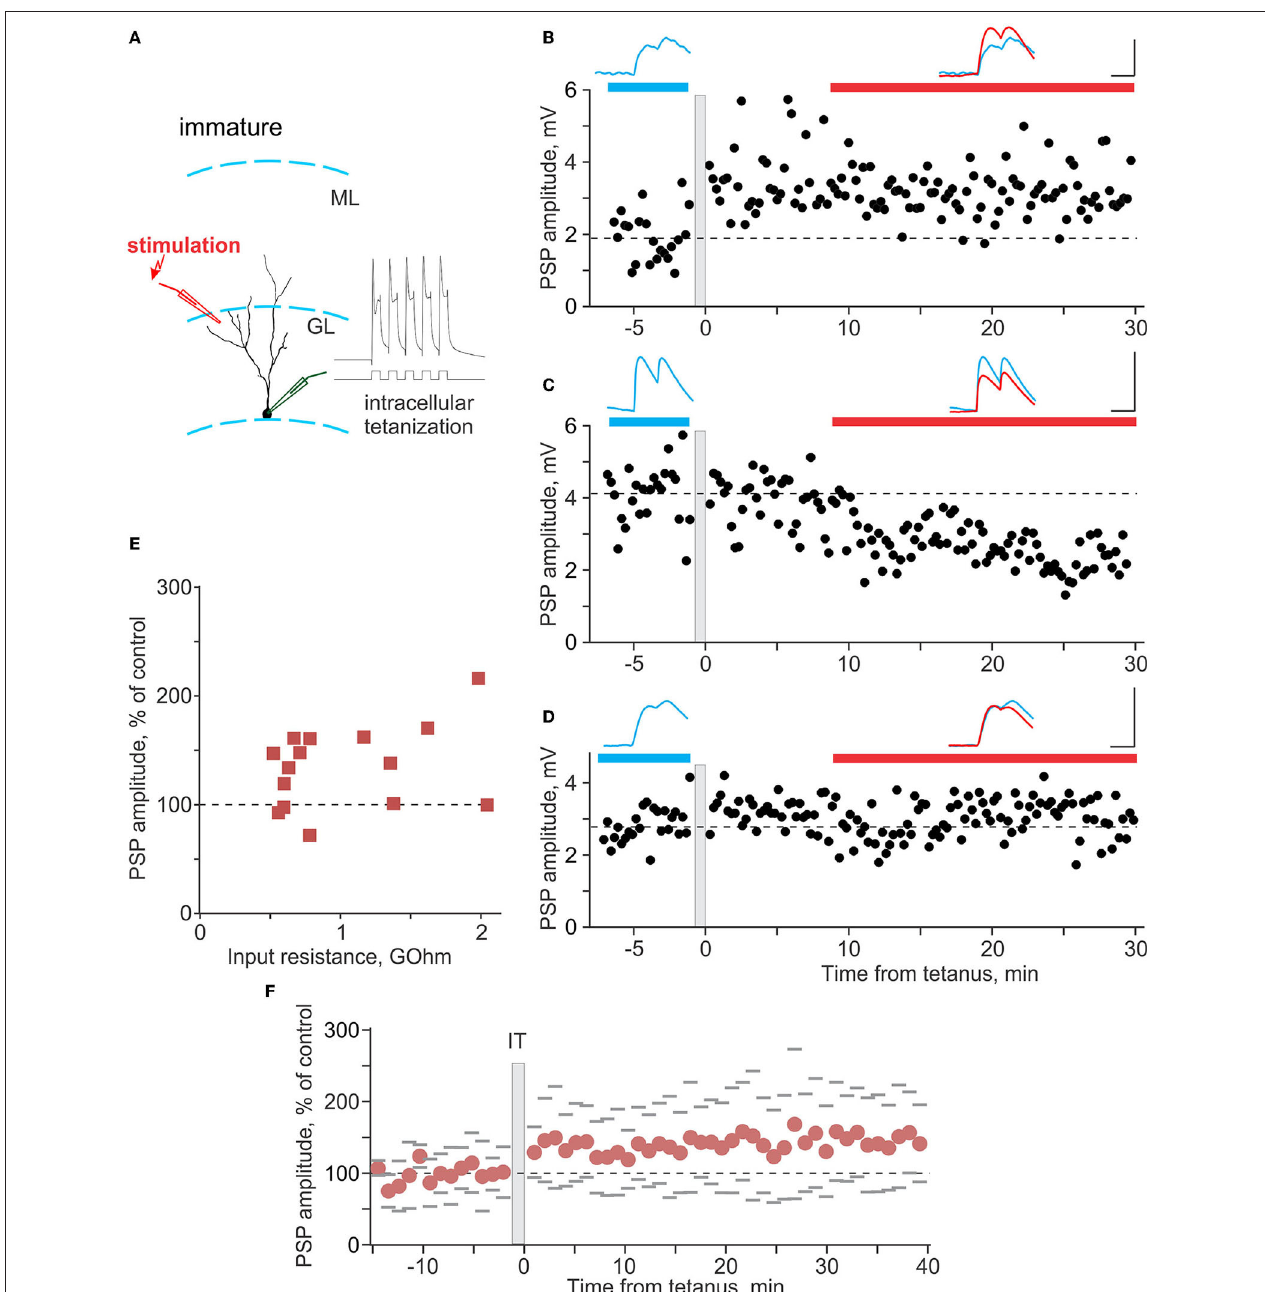
FIGURE 5 | Plasticity induced by intracellular tetanization in immature neurons. (A) A scheme of recording from an immature neuron and location of stimulation electrode, and response of the neuron to one burst of intracellular tetanization (5 brief depolarizing pulses at 100Hz). (B–D) Three example experiments in which intracellular tetanization induced LTP (B) , LTD (C) , or did not lead to changes of synaptic responses in immature neurons (D) . Each time course shows individual PSP amplitudes, and dashed horizontal line shows mean PSP amplitude before intracellular tetanization (gray vertical bar). PSPs above the plots are averages over the periods indicated by the horizontal bars of respective color, before and after intracellular tetanization. Scale bars: 50ms; 2mV in (B) , 4mV in (C,D) . (E) PSP amplitude after intracellular tetanization, in percentage of control, plotted against input resistance for n = 15 immature neurons. (F) Summary time course of PSP amplitude changes, in percentage of control, in experiments with intracellular tetanization for n = 15 immature neurons. For each cell, PSP amplitudes were normalized to control and then average responses over 1min periods were calculated. These 1-min averages were used to calculate average (circle symbols) and SD across cells. Gray dashes show ±